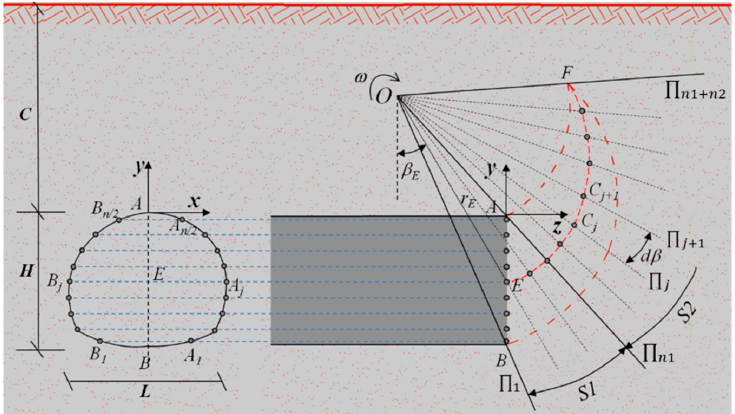
Figure 2. Scheme of the proposed failure model.